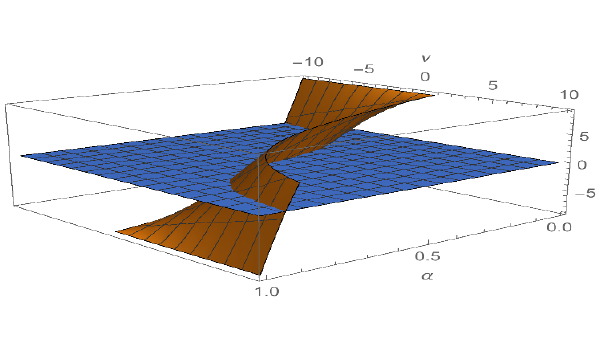
Figure 25. in the (cid:11) and (cid:23) plane at (cid:21) B = 1 F (cid:0) h (cid:0) u is positive or negative. F (cid:0) h (cid:0) u